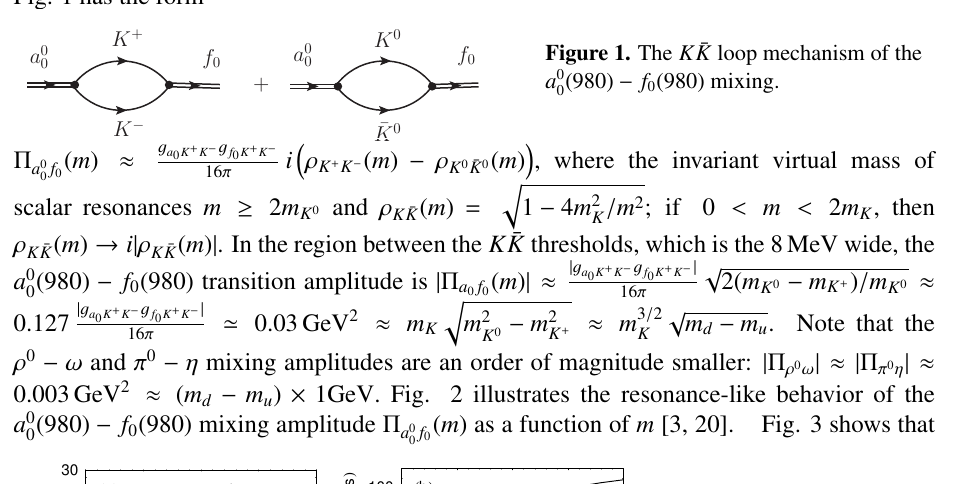
Figure 2. (a) An example of the modulus and (b) the phase of the a 0 (980) − f 0 (980) mixing 0 amplitude in the region of the K + K − and K 0 ¯ K 0 thresholds.